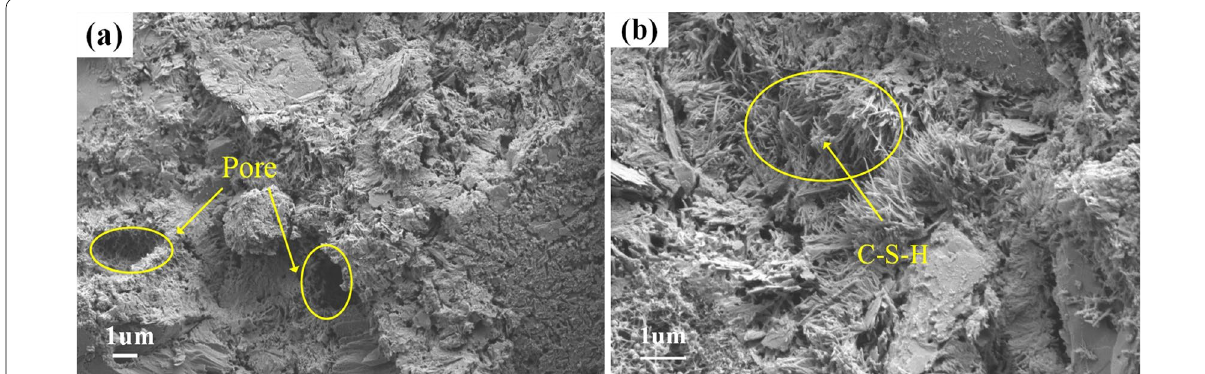
Fig. 5 SEM images of ordinary cement paste: a Morphology of sample surface; b Morphology of C–S–H.